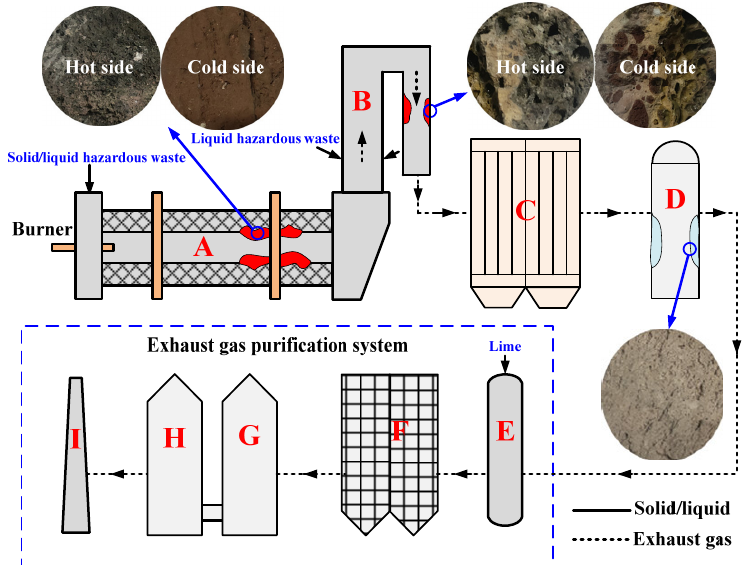
Figure 1. Schematic of the hazardous waste incineration process located in Tengzhou, Shandong, China: ( A ) Rotary kiln, ( B ) Second combustion chamber, ( C ) Waste heat boiler, ( D ) Quench tower, ( E ) Dry deacidification tower, ( F ) Bag-type dust collector, ( G ) Pickling tower, ( H ) Alkaline washing tower, ( I ) Chimney.